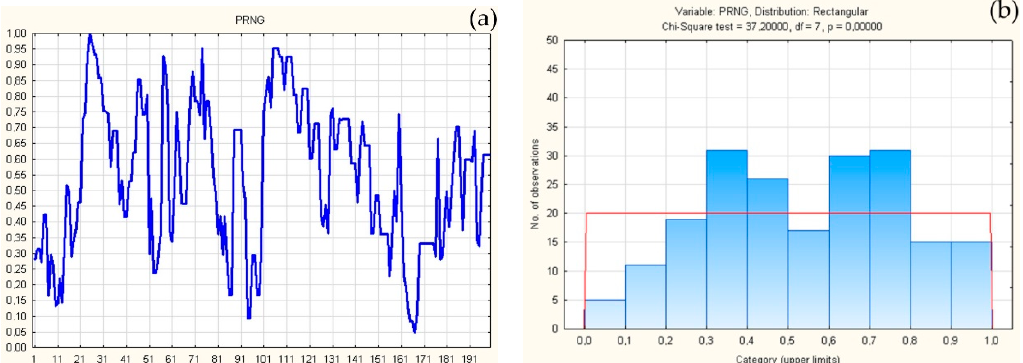
Figure 6. Exponential distributions of all 200 sets Δ↓ [PRNG(i)] ( a ), verifications, and distribution of verifications ( b ).